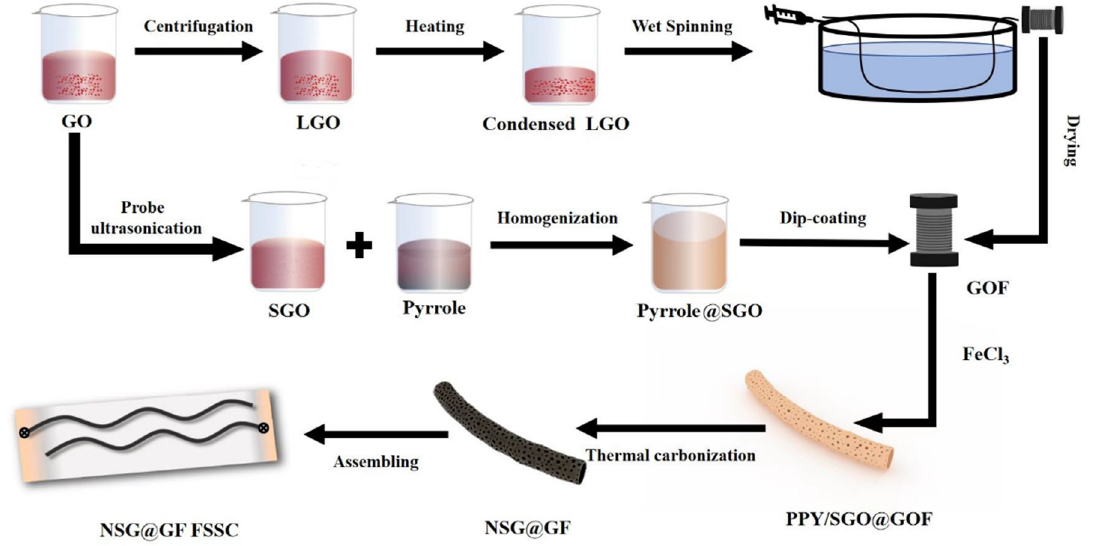
Figure 1. Schematic illustration for the preparation of PPY/SGO@GOF and NSG@GF FSSC.